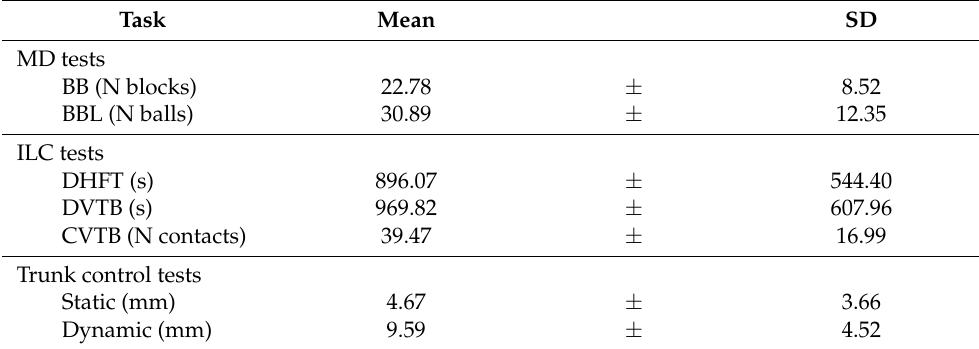
Table 1. Means and standard deviations of the manual dexterity (MD), intra-limb coordination and trunk control tests.